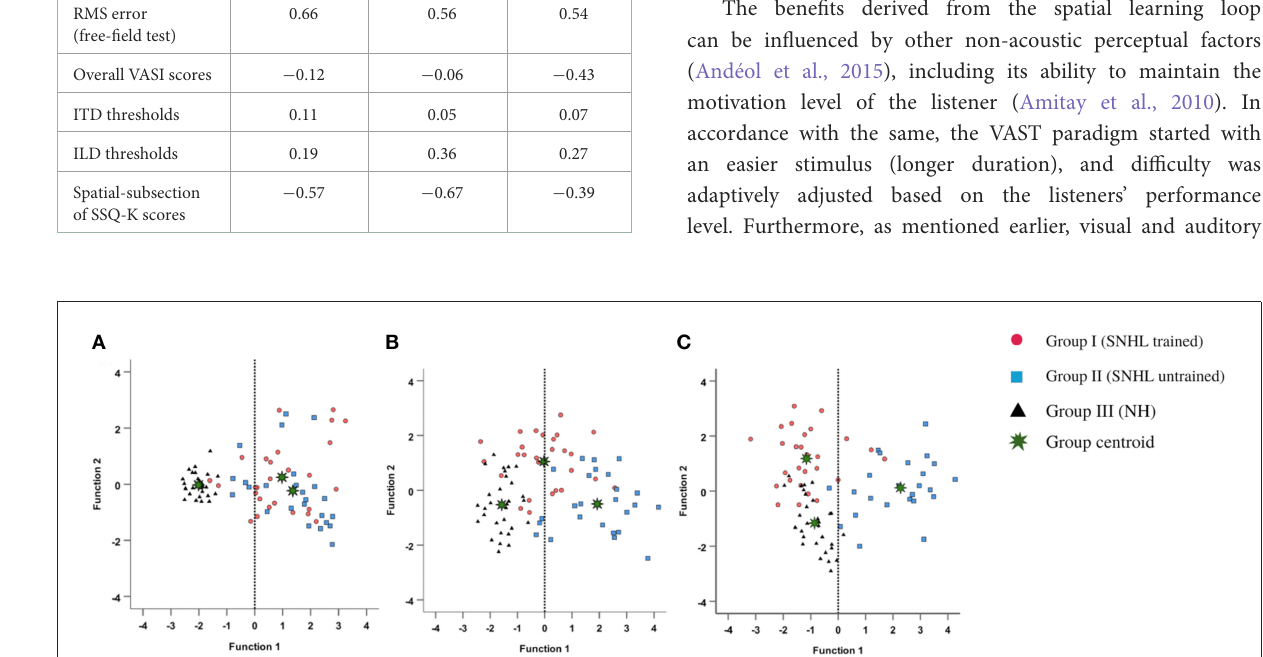
TABLE 4 Contribution (weights) of auditory spatial measures for group membership on discriminant function 1 (DF 1 ). Predictor variable/tests